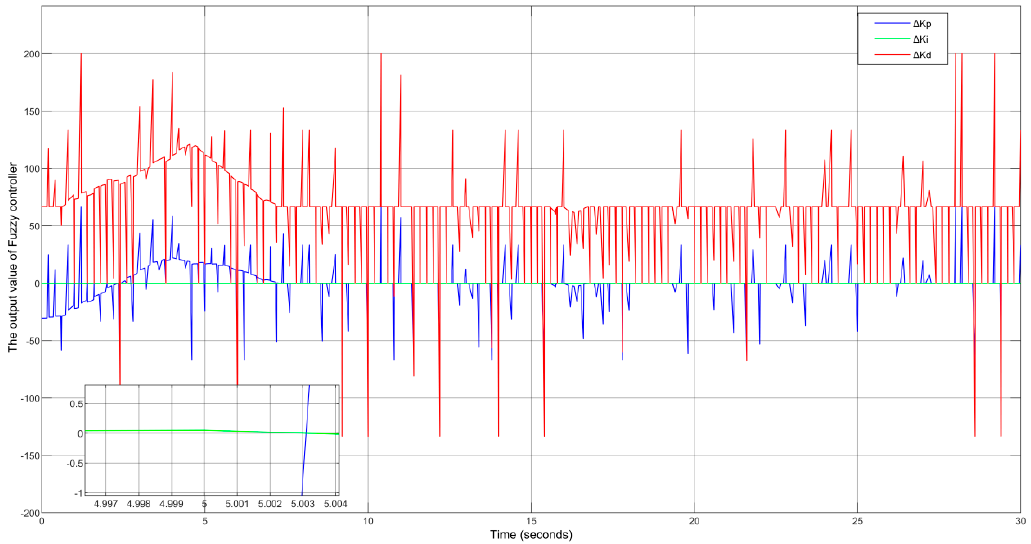
Figure 14. The output results of the PID gain of the fuzzy controller for trolley positioning under working condition 1. Table 9. Parameters of the crane under four working conditions.